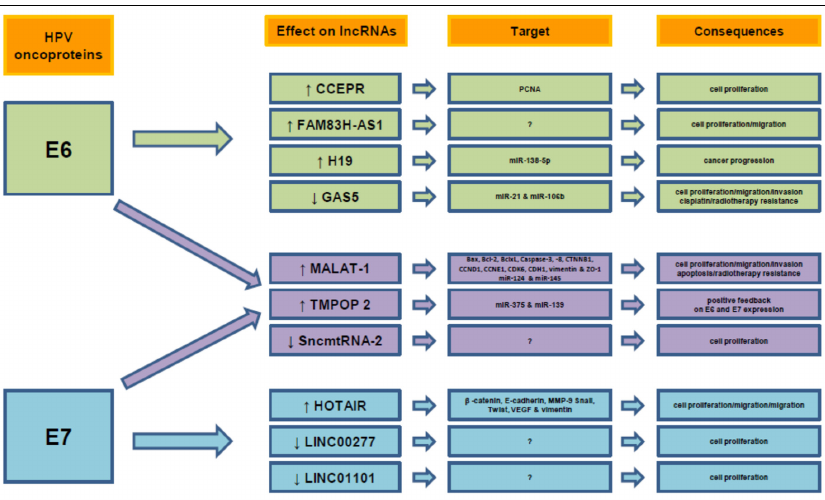
Figure 2. Schematic diagram of Human Papilloma Virus (HPV) E6 / E7 oncoproteins a ff ecting long non-coding RNAs (lncRNAs) expression in cervical squamous cell carcinoma. Bax, bcl-2-like protein 4; BclxL, B-cell lymphoma-extra large; Bcl-2, B-cell lymphoma 2; CCEPR, cervical carcinoma expressed PCNA regulatory; CDH1, E-cadherin; CDK6, cell division protein kinase 6; CCND1, cyclinD1; CCNE1, cyclinE; CTNNB1, b-catenin; FAM83H-AS1, FAM83H Antisense RNA 1; GAS5, growth arrest-specific transcript 5; HOTAIR, HOX transcript antisense RNA; MALAT-1, metastasis associated lung adenocarcinoma transcript 1; MMP-9, metalloproteinase-9; PCNA, proliferating cell nuclear antigen; TMPOP2, Thymopoietin pseudogene 2; VEGF, vascular endothelial growth factor; ZO-1, zonula